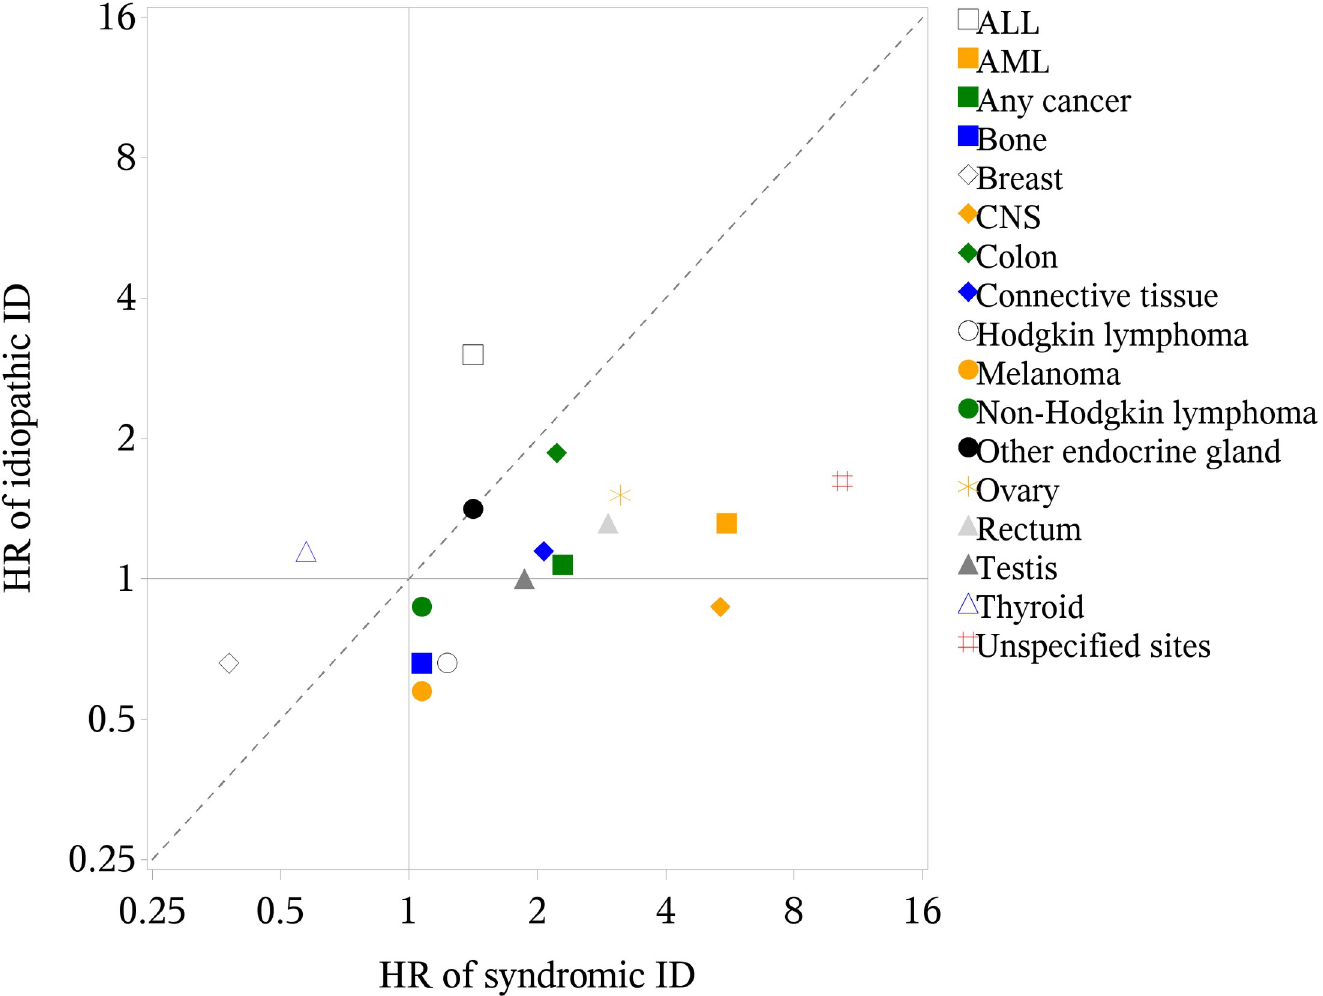
Fig 2. HRs of cancer, by cancer type, among patients with idiopathic versus syndromic ID, compared to the reference group. ALL, acute lymphoid leukemia; AML, acute myeloid leukemia; CI, confidence interval; CNS, central nervous system; HR, hazard ratio; ID, intellectual